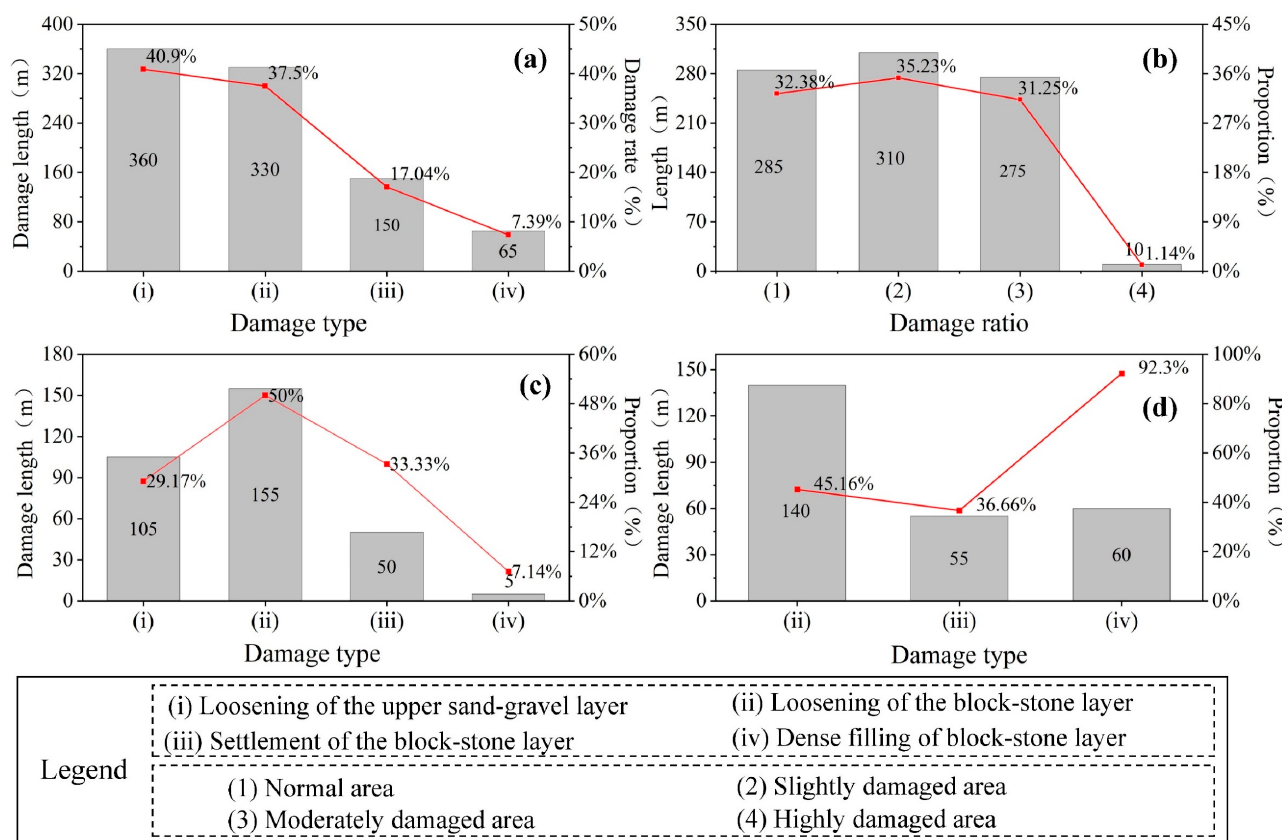
Figure 14. Relationship of different types of damage in the block-stone embankment: ( a ) shows the damaged length and rate of the different types of damage; ( b ) shows the length and proportion of highway sections with different degrees of damage; ( c ) shows the relationship between the different types of damage and the abnormality of the lower part of the embankment; ( d ) shows the relationship between the different types of damage and the loosening of the upper sand-gravel layer.